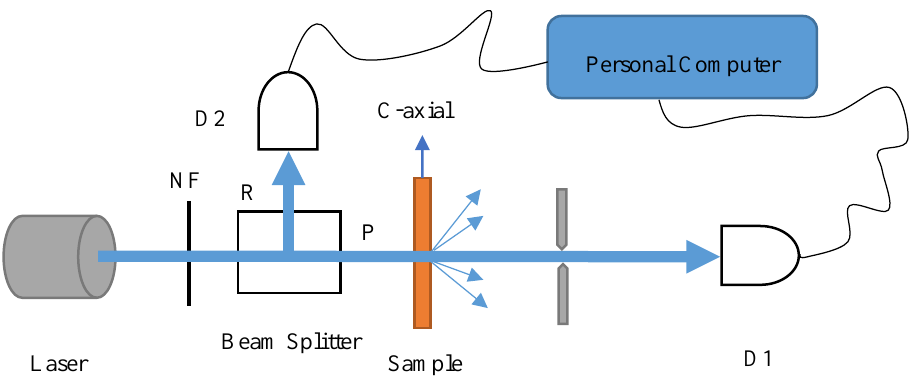
Figure 3. Experimental setup of light-induced scattering measurement.